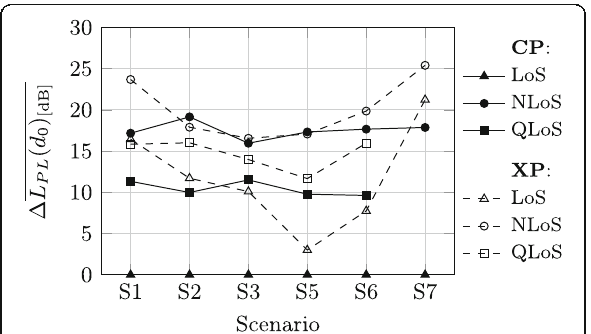
Fig. 4 Relative path loss at reference